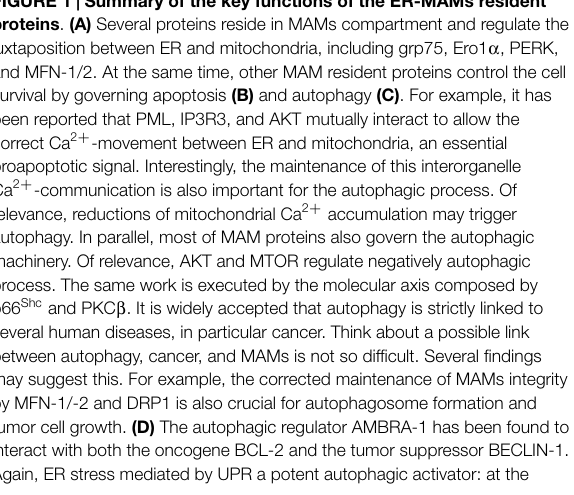
same time ER stress is a critical signal capable to drive cell death. Also, the activity of the main proteins involved in Ca 2 + release and reuptake at MAM levels, SERCA and IP3R3, is reported to be involved in apoptosis and tumorigenesis. Interestingly, the functioning of these channels is